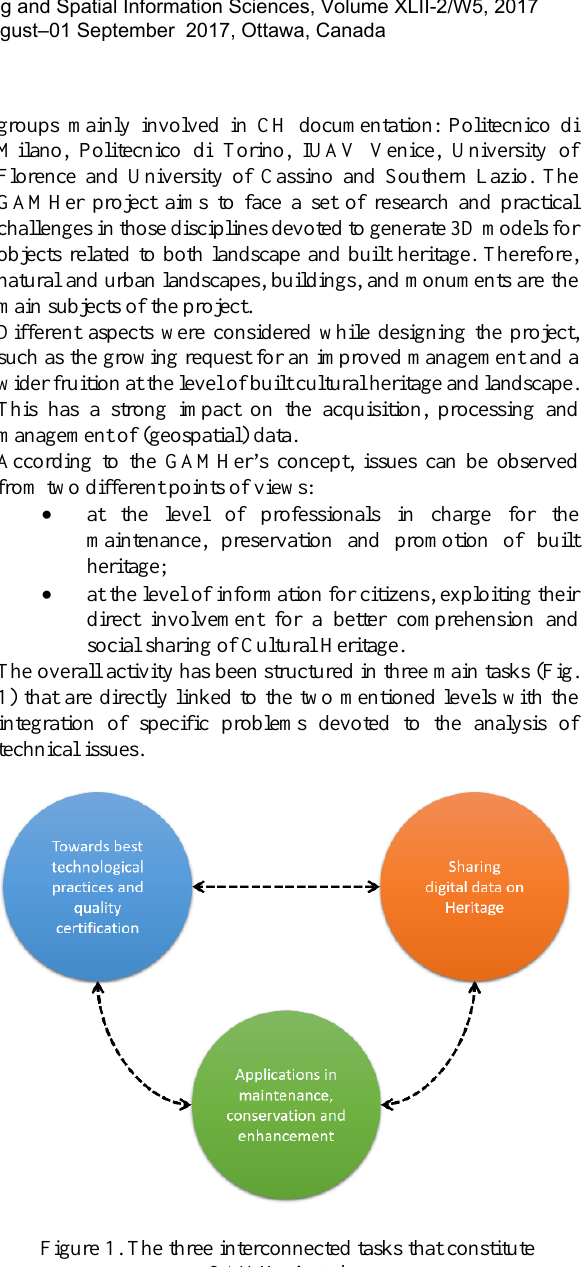
Figure 1. The three interconnected tasks that constitute GAMHer’s